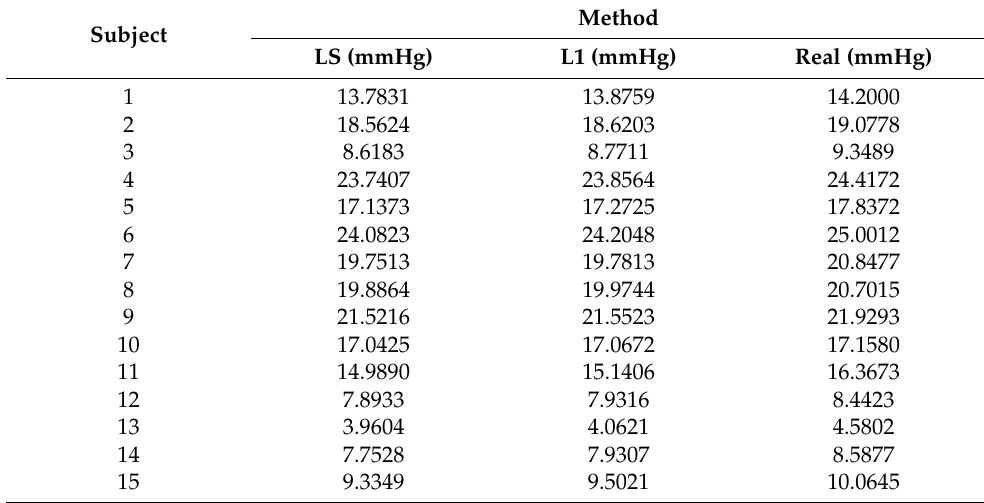
Table 10. The mean of the intracranial pressure (ICP) data.